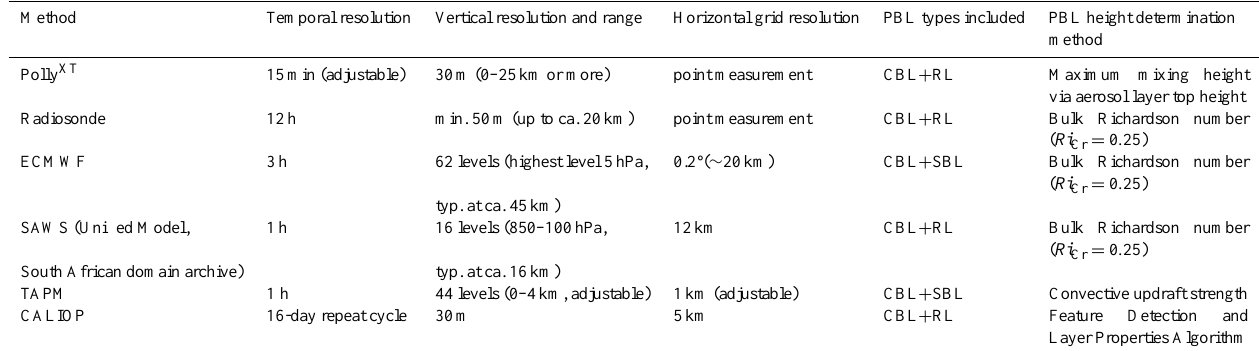
Table 1. The main properties of the methods used in this study.